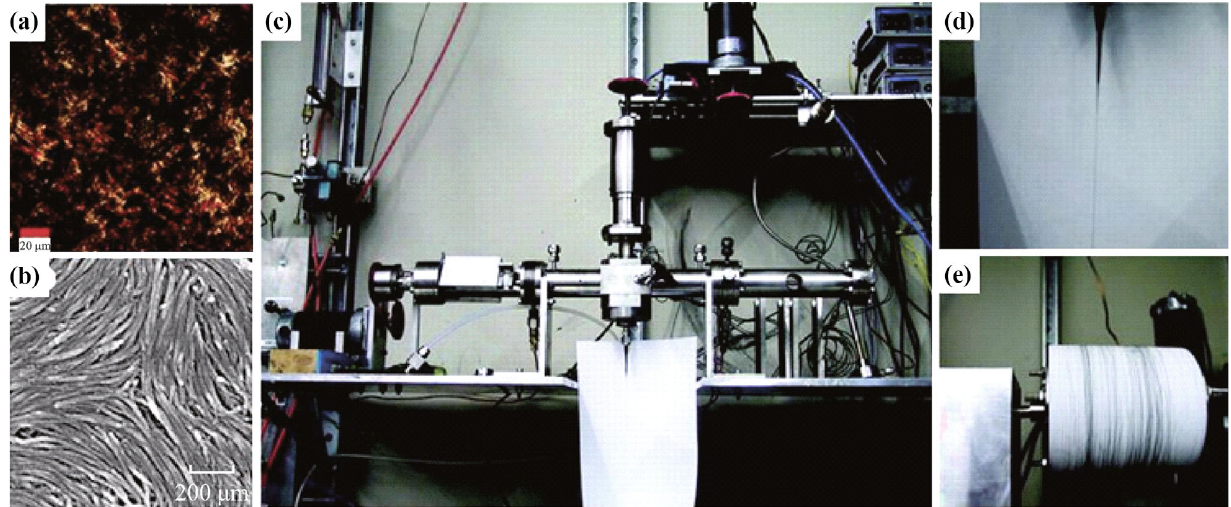
Fig. 2 a Polarizing optical microscopy (POM) observation of the SWNTs dispersed in 123% sulfuric acid. b Field emission gun scanning electron microscope (FEGSEM) image of a - 1/2 disclination in the nematic phase for CNTs. c The apparatus used for mixing and extruding neat SWNT fibers. d A jet of SWNT dispersion being extruded from a capillary tube. e A 30-m-long spool of water-coagulated SWNT fiber. a , b Reproduced with permission from Ref. [13, 14]. Copyright 2006, American Chemical Society. c – e Reproduced with permission from Ref.